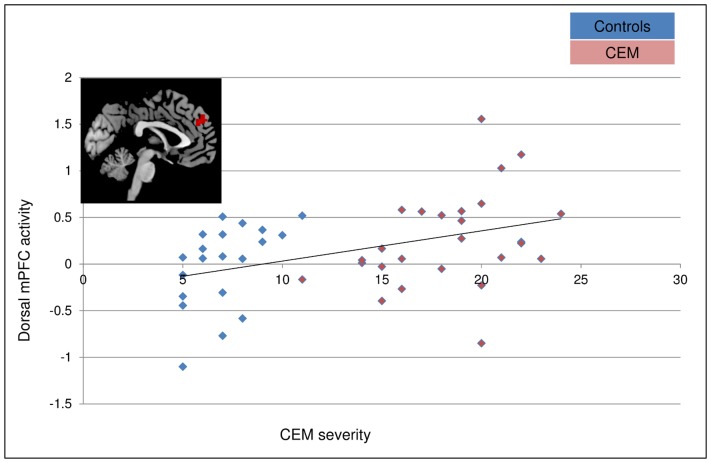
Relationship dorsal mPFC and CEM severity.